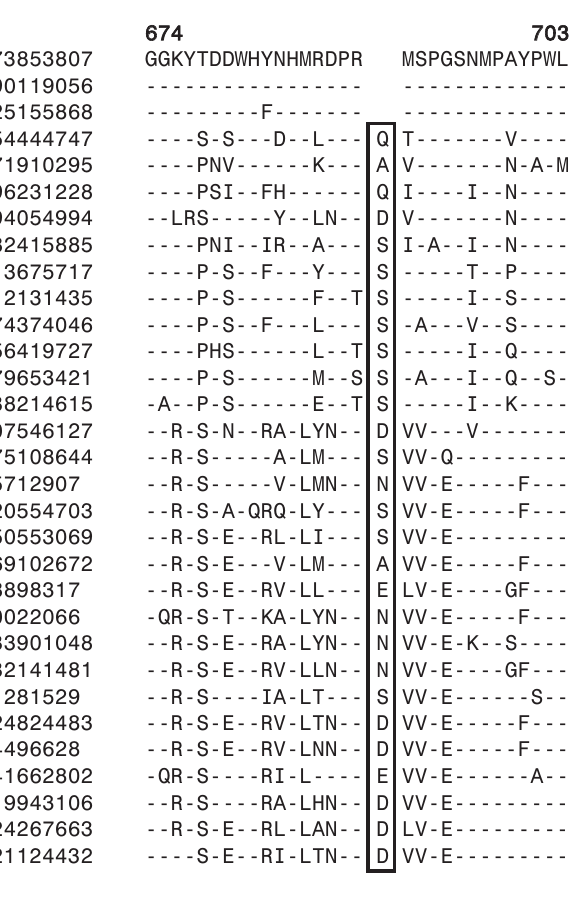
bacteriumTav5, and Diplosphaera colitermitum species. The three species harboring the indel also branch together in the concatenated protein